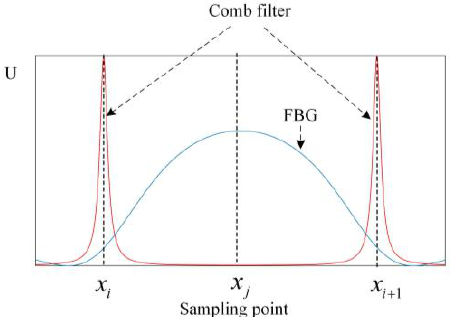
Figure 12. Light spectra of the FBG and the comb filter during the upslope of the triangular wave.